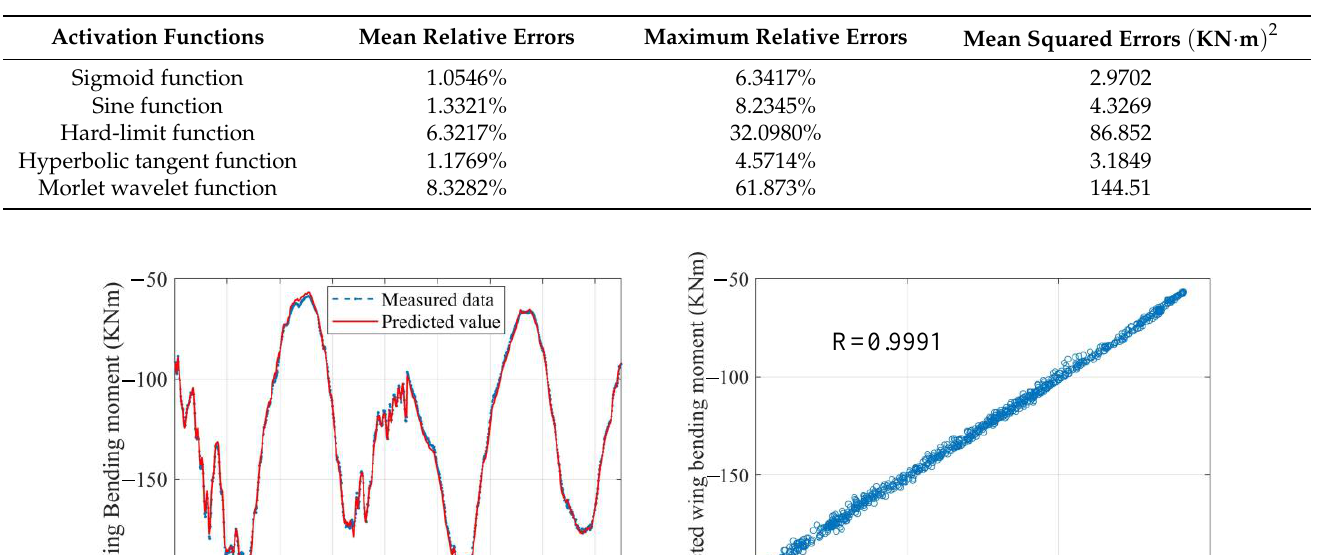
Figure 7. Demonstration of five investigated activation functions: ( a ) sigmoid function, hard-limit function, and hyperbolic tangent function; ( b ) sine function and Morlet wavelet function. Table 2. Prediction accuracy of wing bending moments under different activation functions.